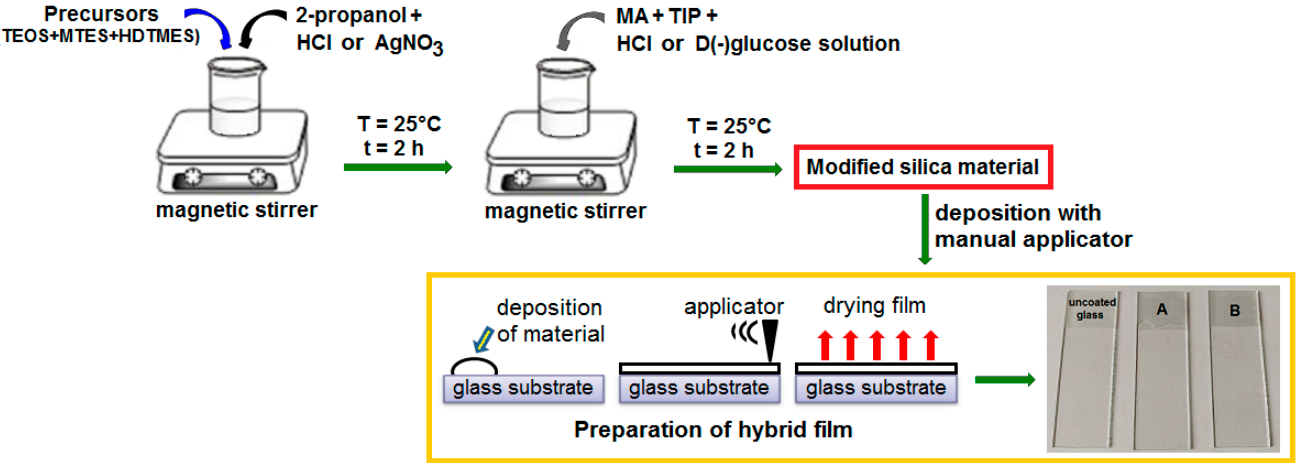
Figure 1. Schematic representation of the sol–gel method to obtain the silica materials (without AgNPs (sample A) and with AgNPs (sample B)) and to prepare the hybrid